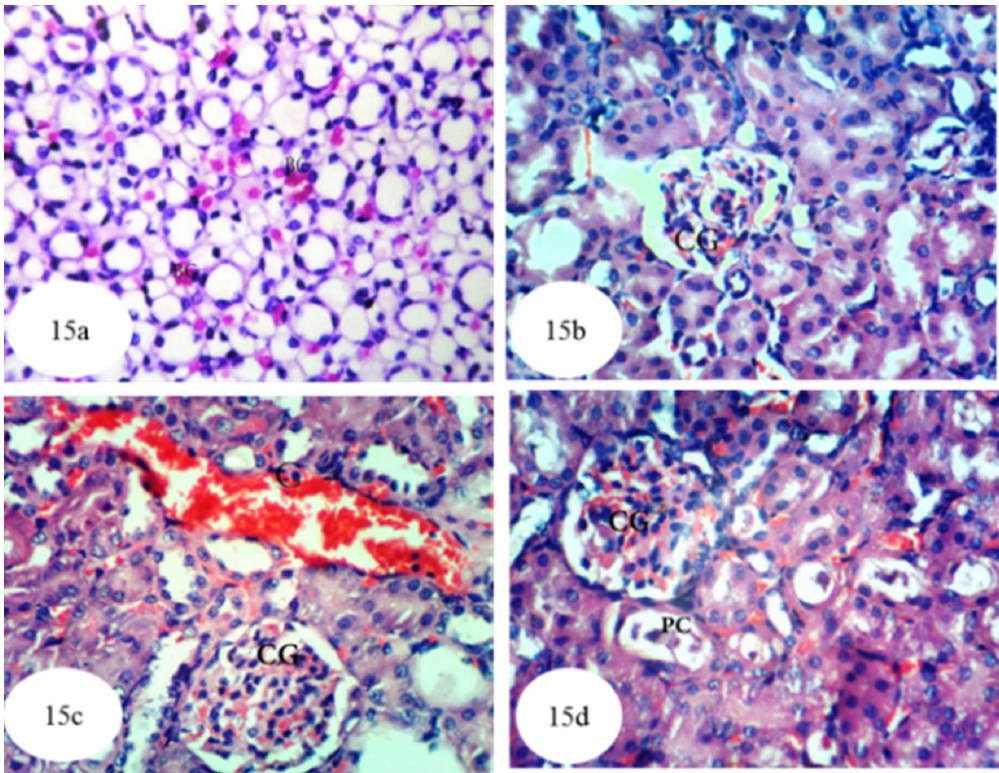
Figure 15. Photomicrographs of hematoxylin and eosin stained sections of kidney of ethylene glycol-administered rat treated with A. bisporus aqueous extract showing few red blood cells (BC) in the tubular lumen and in between the tubules at the medulla ( a ) (×256); normal renal structure with slight glomerular congestion (CG) ( b ) (×400); congestion (C) of renal blood vessels and glomeruli (CG) ( c ) (×400); and small protein casts (PC) in the lumen of some renal tubules and mild congestion in the glomeruli (CG) ( d ) (×400).